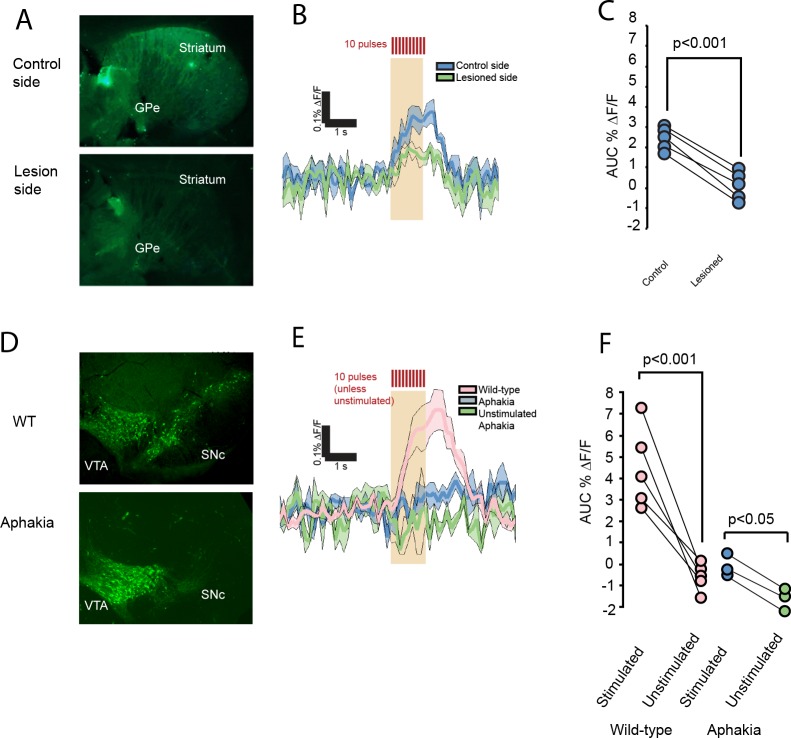
FFN102 transients are ablated in dopamine depleted mice.(A) Representative images of slices in 6-OHDA experiments, post-fixed after imaging and immunolabeled for tyrosine hydroxylase. (B) Evoked transients from control side, blue, or lesioned side, green (n = 5 slices from five mice for each condition; shading represents SEM). (C) The lesioned hemispheres show decreased transients (average difference of 2.46, CI95 = [2.10, 2.82], two-tailed paired t-test p < 0.001). (D) Representative immunolabel for tyrosine hydroxylase in wild-type and aphakia mice shows a decreased label in the SNc, but not VTA. (E) Evoked transients wild-type mice of the same background, pink, aphakia mice, blue, and unstimulated aphakia mice, green (shading represents SEM). (F) Comparison of stimulation-evoked fluorescence changes in aphakia and wild-type mice (average difference in AUC %ΔF/F = 4.54 (CI95 = [3.05, 6.03], n = 5 slices from five mice for WT experiments, p < 0.001); between stimulated and unstimulated slices from aphakia mice, the average difference in the AUC %ΔF/F = 1.46 (CI95 of difference = [1.00, 1.91]; n = 3 slices from three mice for aphakia experiments; p < 0.05).